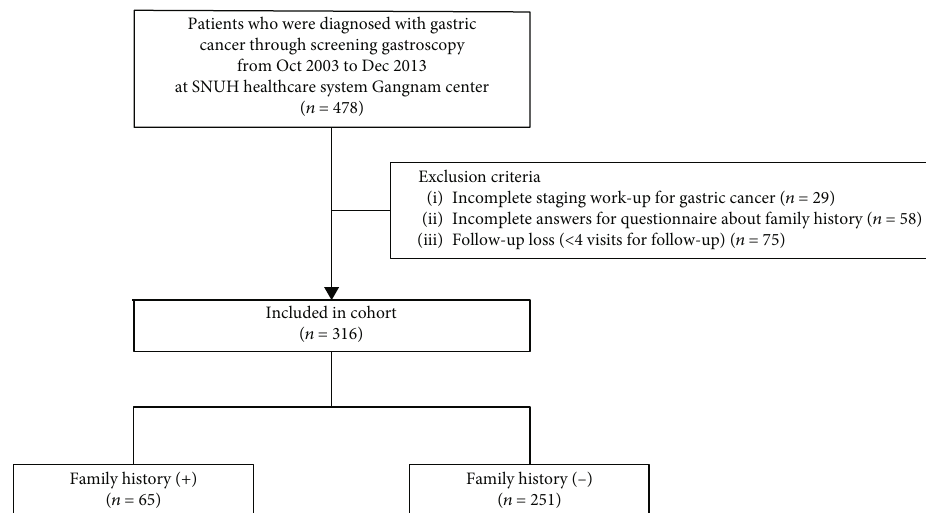
Figure 1: Flow chart of enrollment of the study population. Table 1: Demographic fi ndings of study population. Family history of